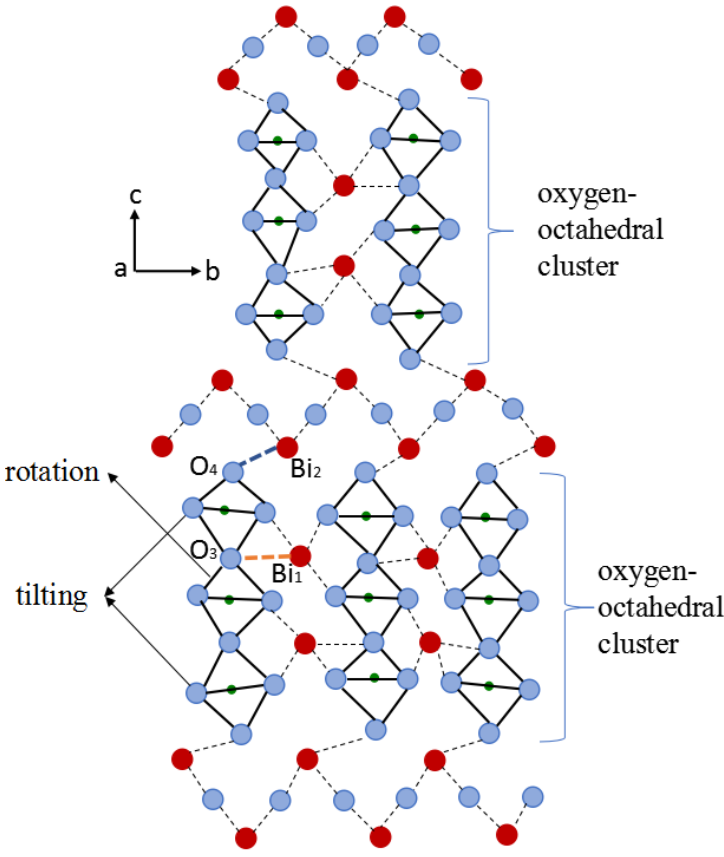
Figure 4. Cutaway drawing of Bi 4 Ti 3 O 12 structures viewed along [100]. Octahedra (like rhombus) are outlined in solid lines, and dashed lines indicate the strong Bi–O bonds.